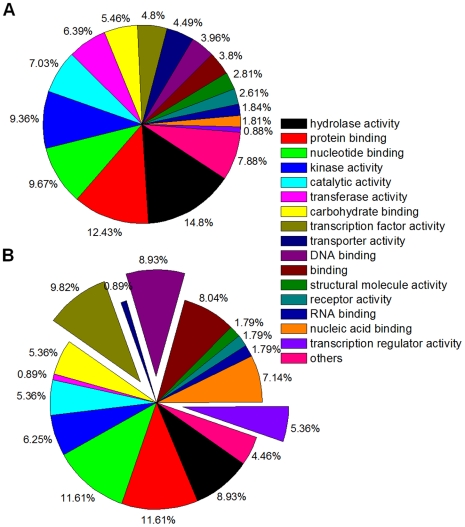
Function classification of rice pseudogenes.Panel A is for all pseudogenes and panel B is for group A pseudogenes (Figure 3) with antisense small RNAs in developing rice grains. The GO terms of a pseudogene were transferred from its parent gene with the functional categories defined by TIGR Gene Ontology (GO). A “*” indicates the significantly enriched GO in 145 pseudogenes with antisense small RNAs.